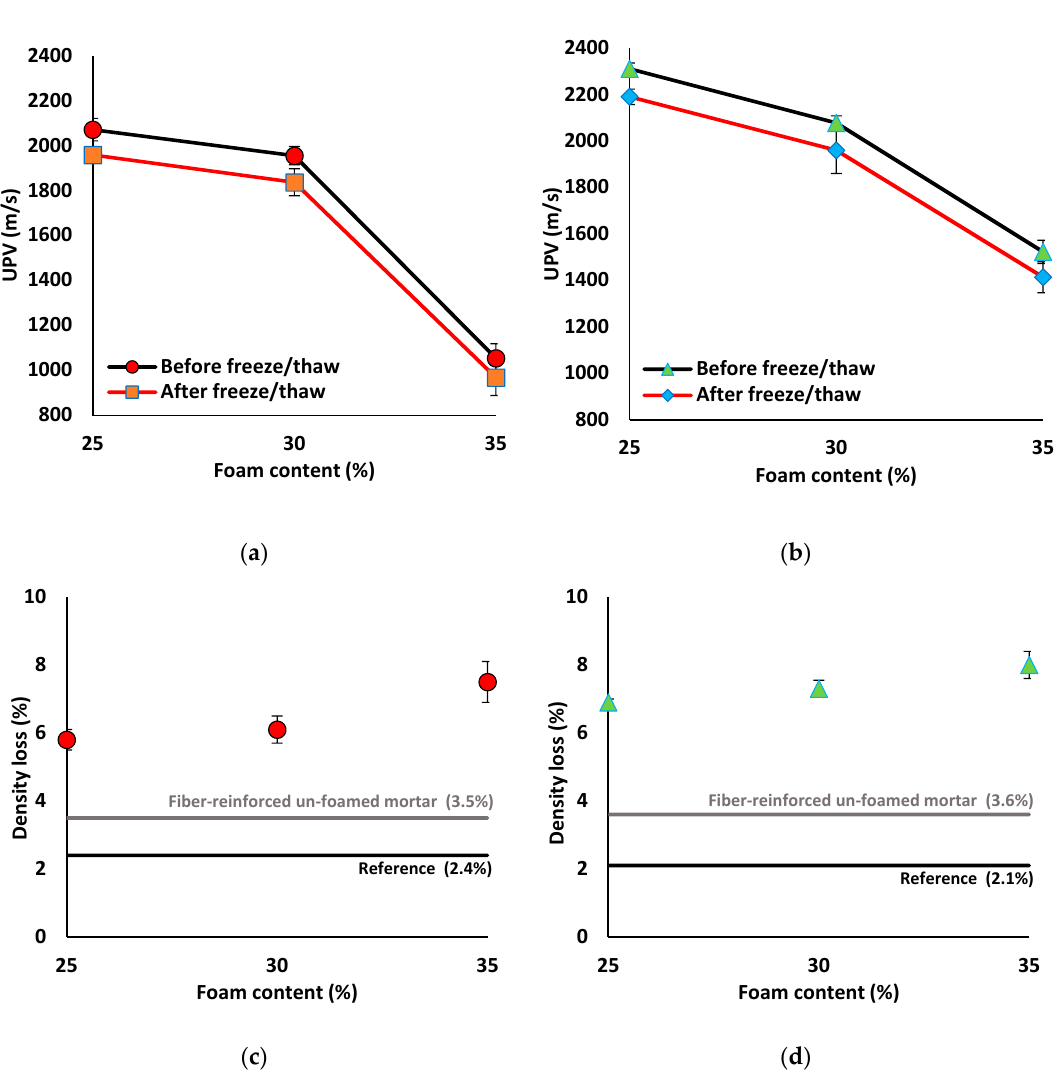
Figure 14. Effects of the freeze/thaw cycles on the UPV results of mix compositions: ( a ) SW50/GW10; Figure 14. E ff ects of the freeze / thaw cycles on the UPV results of mix compositions: ( a ) SW50 / GW10; ( b ) SW30/GW30; and on density loss (%) of mix compositions: ( c ) SW50/GW10; ( d ) SW30/GW30. ( b ) SW30 / GW30; and on density loss (%) of mix compositions: ( c ) SW50 / GW10; ( d ) SW30 /